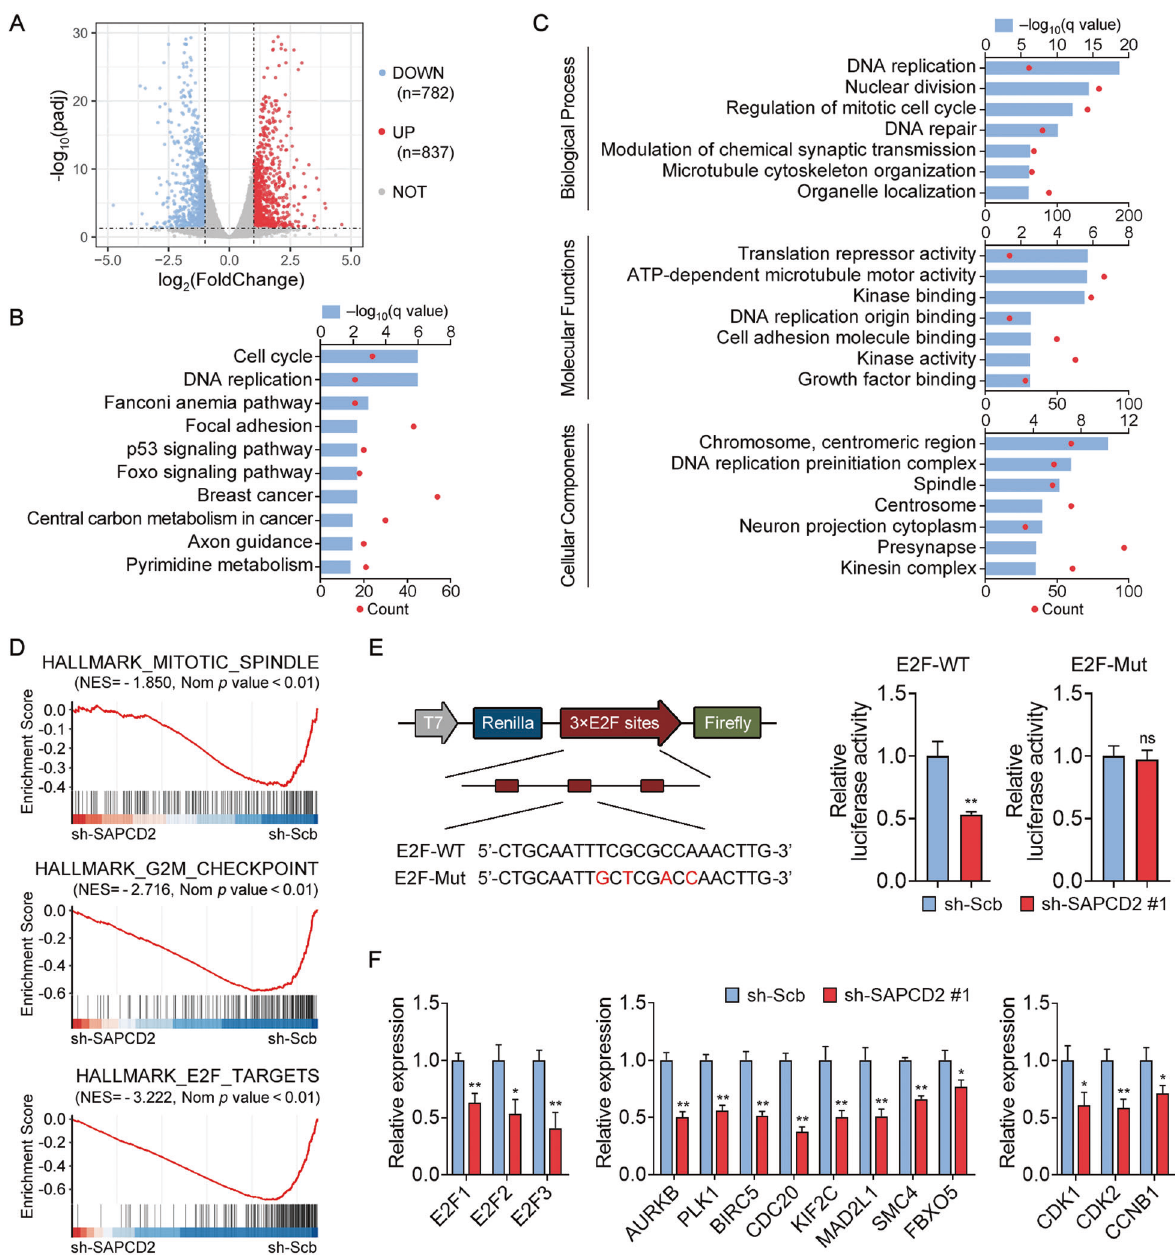
Fig. 3 Transcriptome analysis of SAPCD2-dependent regulation. A Volcano plot of all expressed genes is shown to identify DEGs obtained from RNA-seq data in SAPCD2-knockdown SK-N-BE(2) cells with abs(log 2 (fold change)) >1 and adjusted p value <0.05. B , C KEGG pathway analysis ( B ) and GO analysis ( C ) for DEGs. D Enrichment plots generated from GSEA hallmark gene set using DEGs upon SAPCD2-knockdown. NES normalized enrichment score. NOM p value, adjusted p value. E Activity of the dual-luciferase reporter vector containing WT or mutant E2F-binding motifs that were transfected into SK-N-BE(2) cells transfected with sh-Scb or sh-SAPCD2. F qPCR analysis of mRNA levels for the indicated E2F transcription activators, E2F target genes, and cell cycle-related genes in SK-N-BE(2) cells transfected with sh-Scb or sh-SAPCD2. Unpaired two-sided t -test for analysis in E – F , data were shown as mean ± SD (error bars). ns, not signi fi cant. Data were representative of three independent